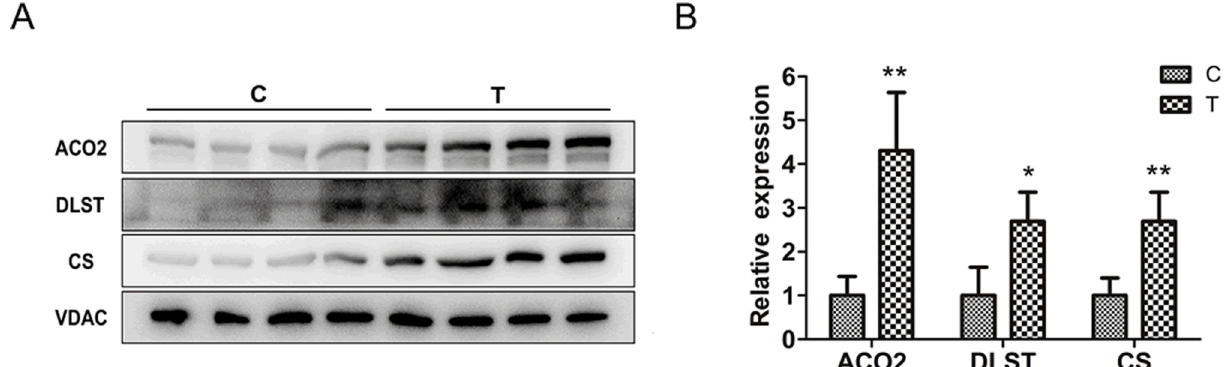
Fig 4. 28-day tail suspension promotes the expression of ACO2, DLST and CS in hippocampus mitochondria of rats. (A) Protein levels of ACO2, DLST and CS were determined by immunoblotting. (B) The relative expressions of ACO2, DLST and CS were represented by the intensity ratio between the protein and the loading control (VDAC) in each lane. n = 4, error bars indicated standard deviations. � p < 0.05; �� p < 0.01 compared with each control group.